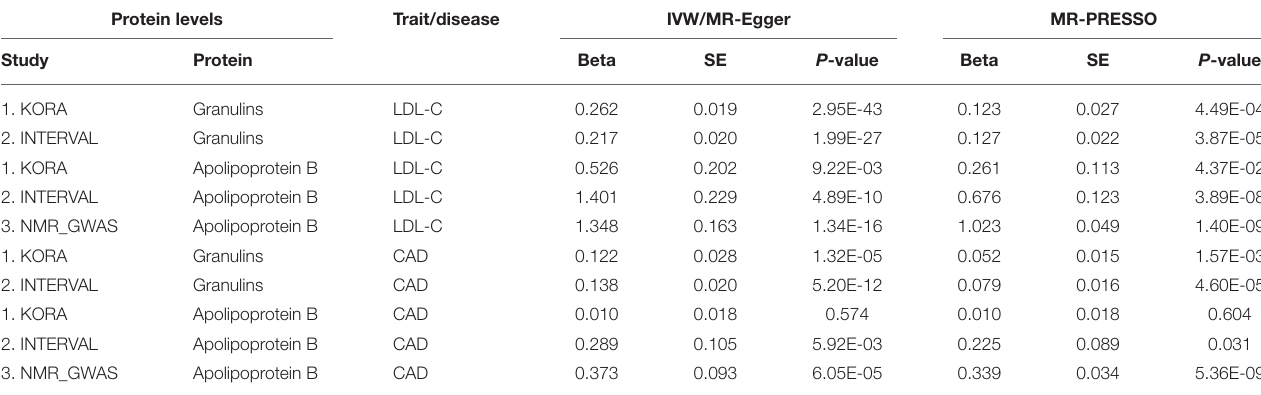
TABLE 3 | The causation between plasma protein levels and LDL-C and CAD. Protein levels Trait/disease